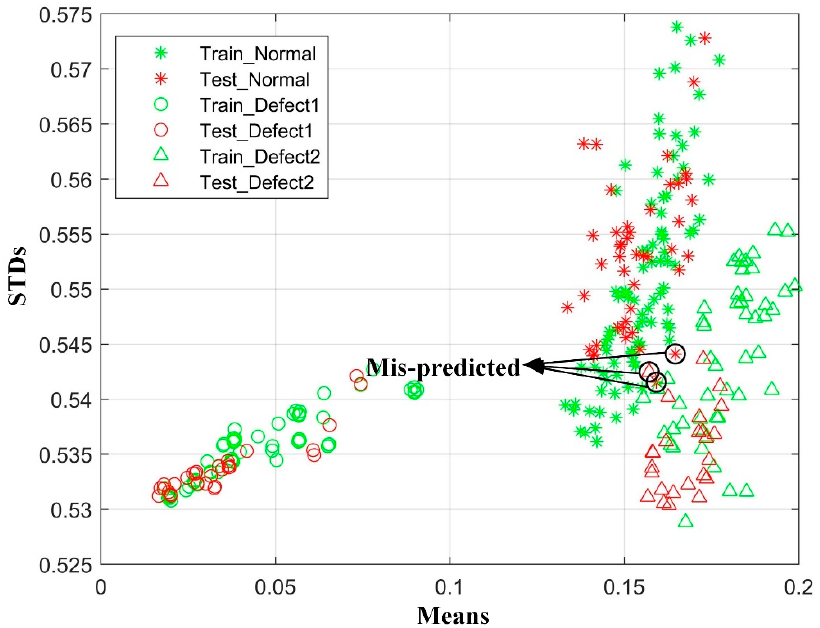
Figure 9. The predicted results for SA, where the green markers represent cells from the training set and the red markers represent the cells from the testing set. The stars, circles, and triangles represent the cells from the normal state, warpage, and material stack. The markers circled by black circles are mis-predicted.